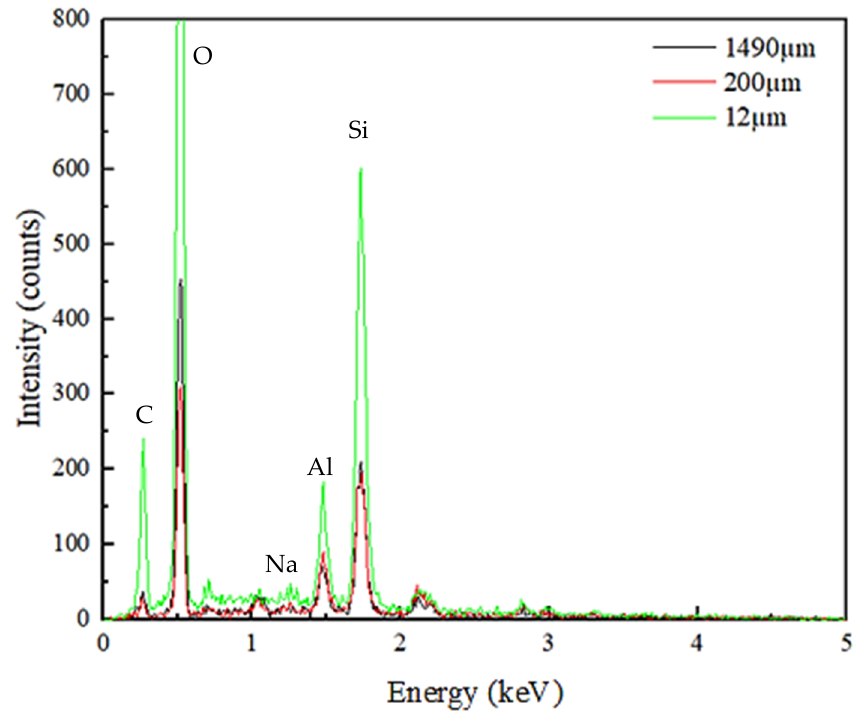
Figure 3. Elemental identification of the zeolite samples obtained from the EDX spectrums.